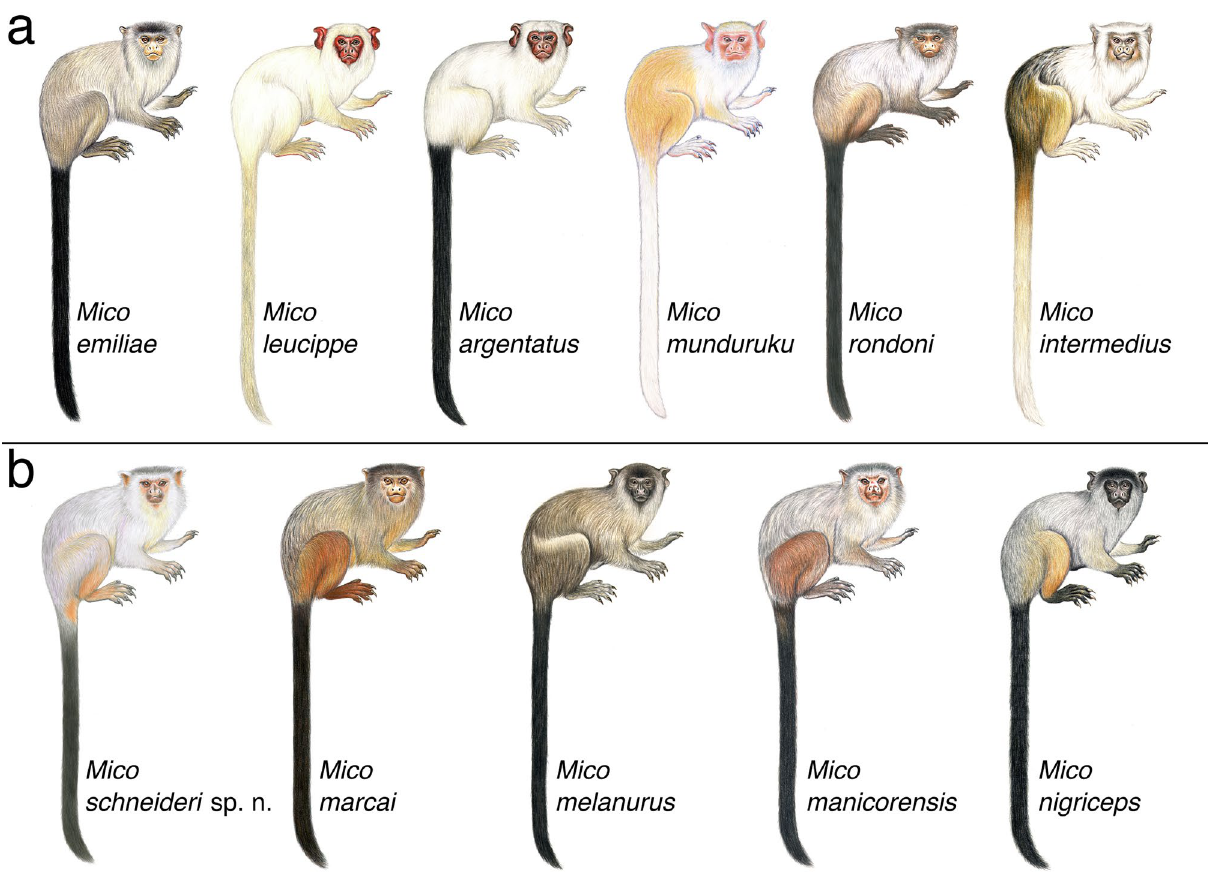
Figure 5. Two of the four lineages retrieved in genus Mico , based on morphological synapomorphies (data not shown) and phylogenomic analyses. (a) Mico emiliae lineage; (b) Mico schneideri sp. n. lineage. Illustrations: Stephen